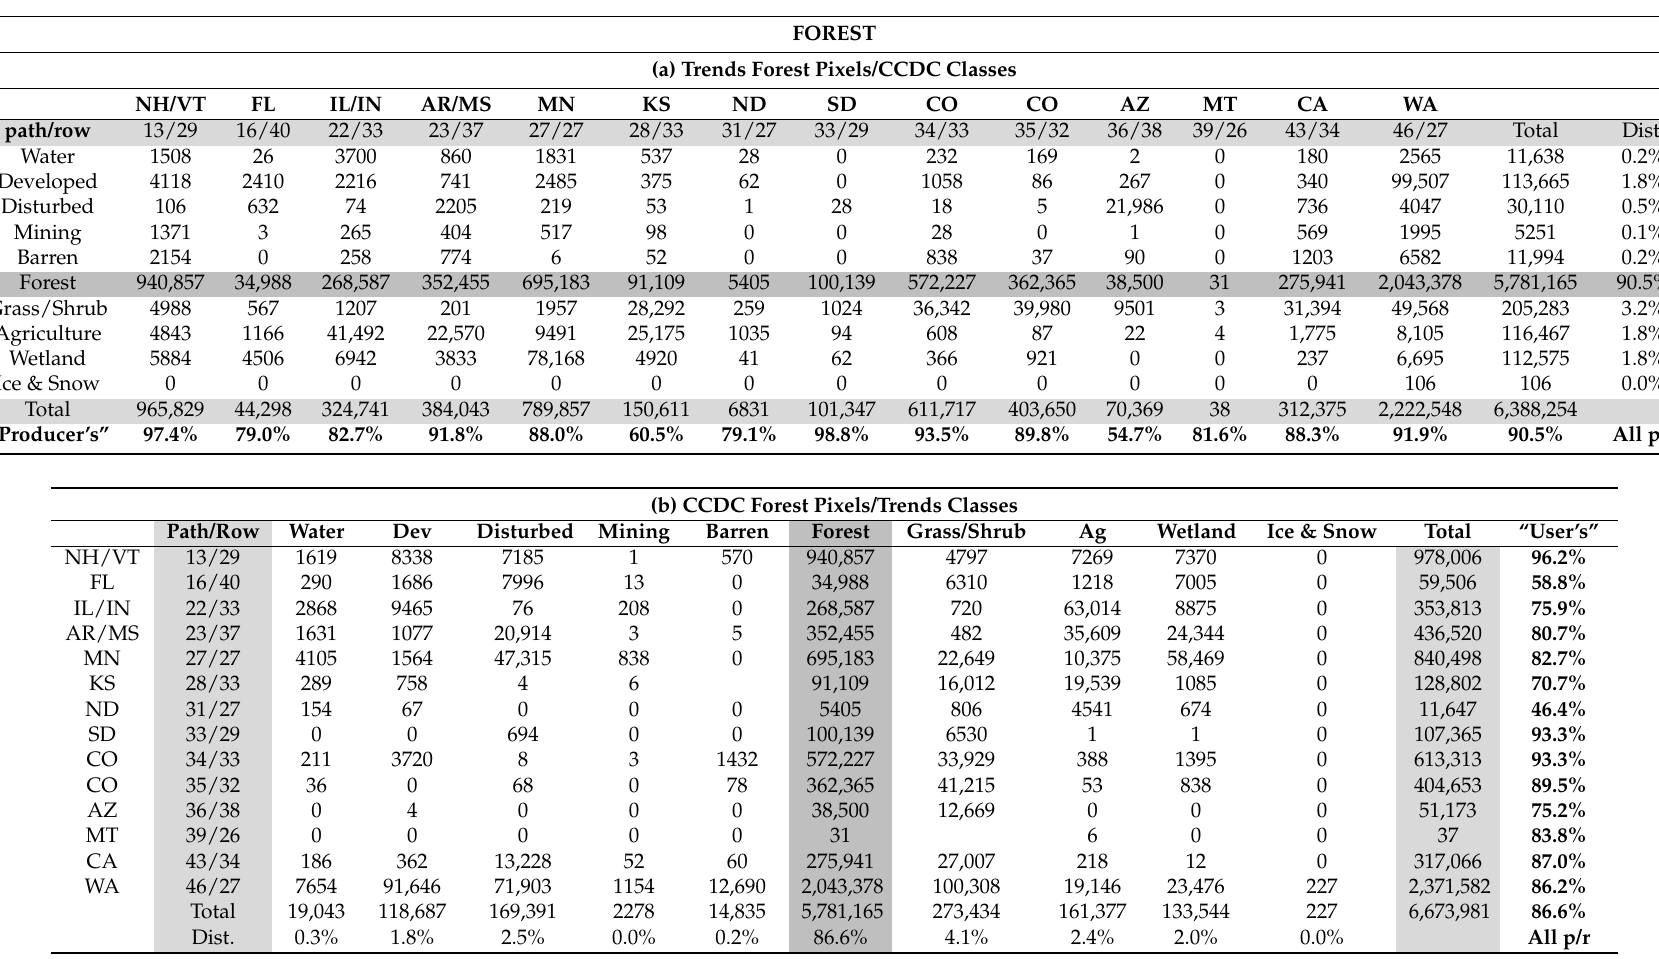
Table 5. (a) Forest pixels mapped by LC Trends distributed across CCDC classes for each path/row location and (b) Forest pixels mapped by CCDC distributed across LC Trends classes for each path/row location. AR = Arkansas; AZ = Arizona; CA = California; CO = Colorado; FL = Florida; IL = Illinois; IN = Indiana; KS = Kansas; MN = Minnesota; MS = Mississippi; MO = Montana; ND = North Dakota; NH = New Hampshire; SD = South Dakota; VT = Vermont; WA =